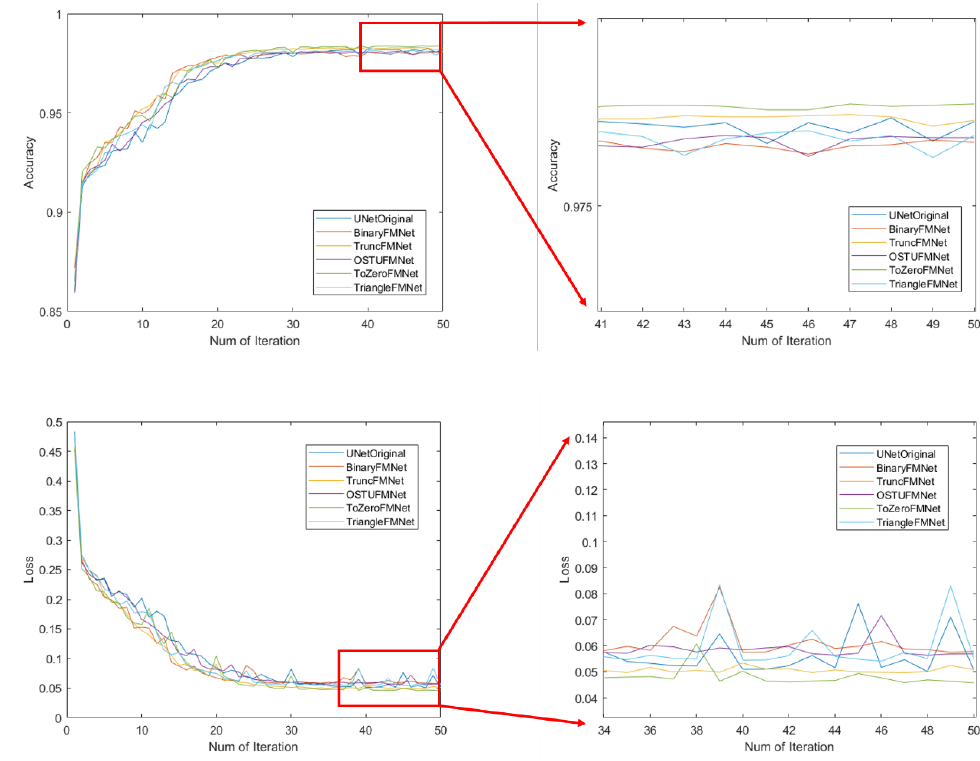
Figure 9. Curve of accuracy and error during training iteration. Table 2. Comparison of training and verification results between six models. N.B. the bold text indicates the best results.